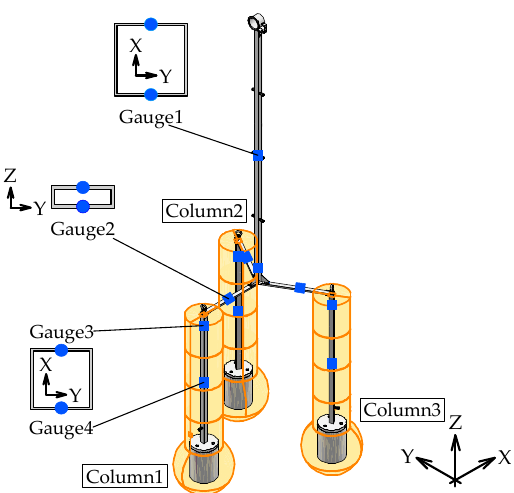
Figure 4. Location of the strain gauges on the experimental model.